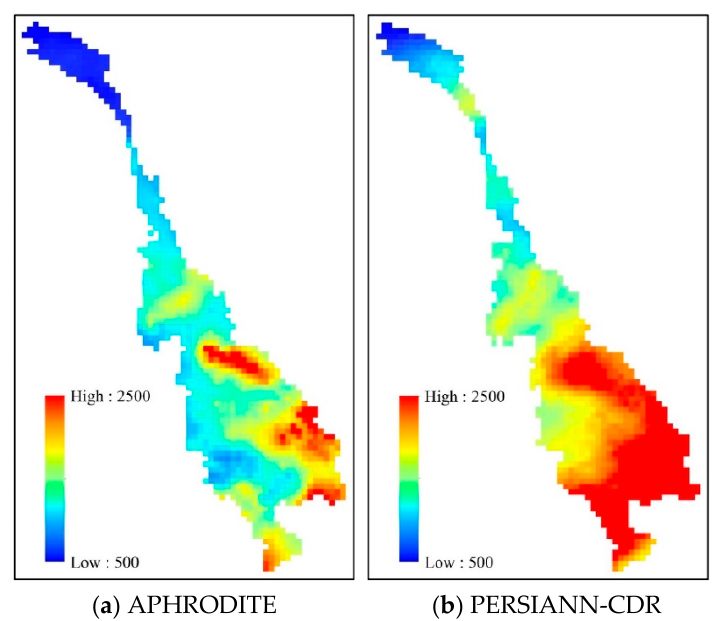
Figure 2. Spatial distribution of the precipitation of two gridded products in the Mekong basin in 2000. APHRODITE: Asian Precipitation-Highly Resolved Observational Data Integration towards Evaluation and PERSIANN-CDR: Precipitation Estimation from Remotely Sensed Information using Artificial Neural Networks-Climate Data Record.